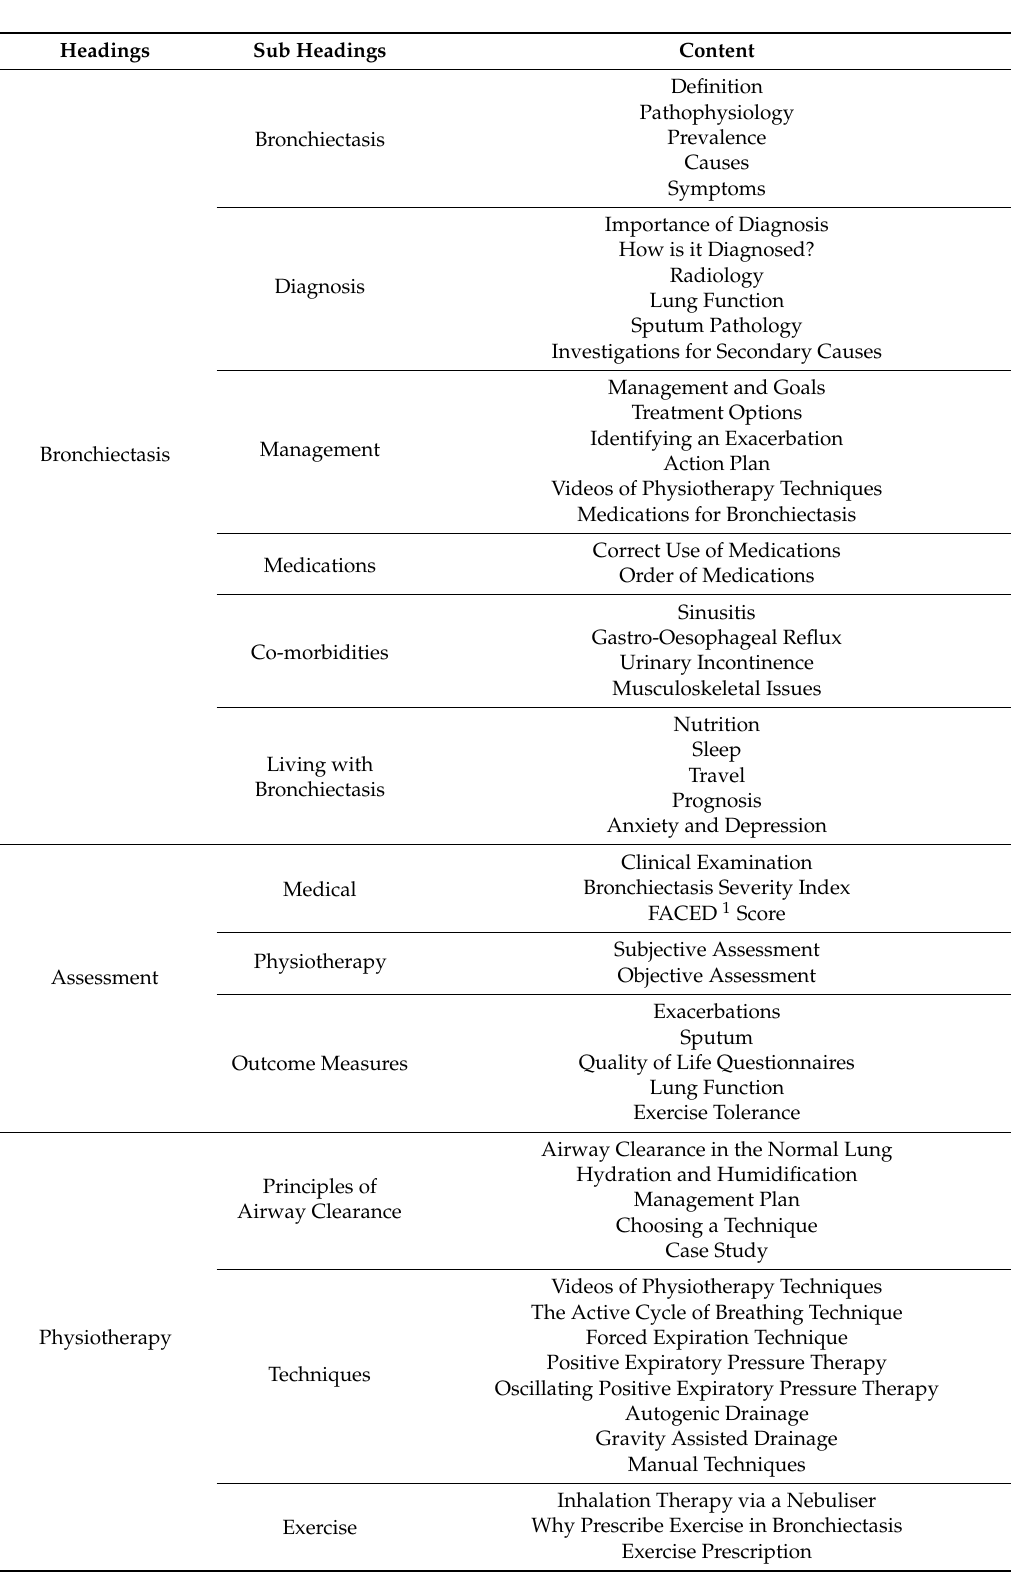
Table 1. Contents of the Bronchiectasis